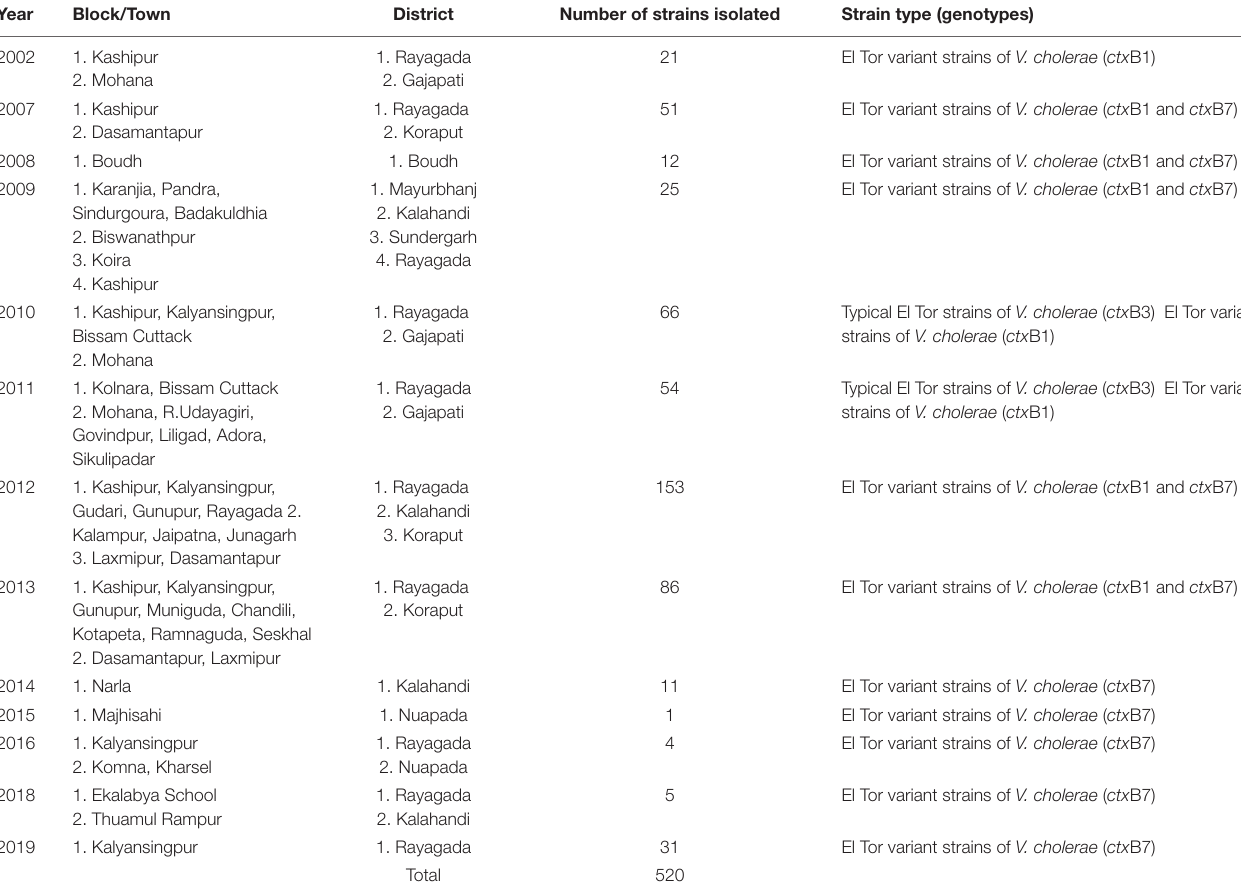
TABLE 4 | Year-wise isolation of Vibrio cholerae O1 strains from the tribal areas of Odisha: